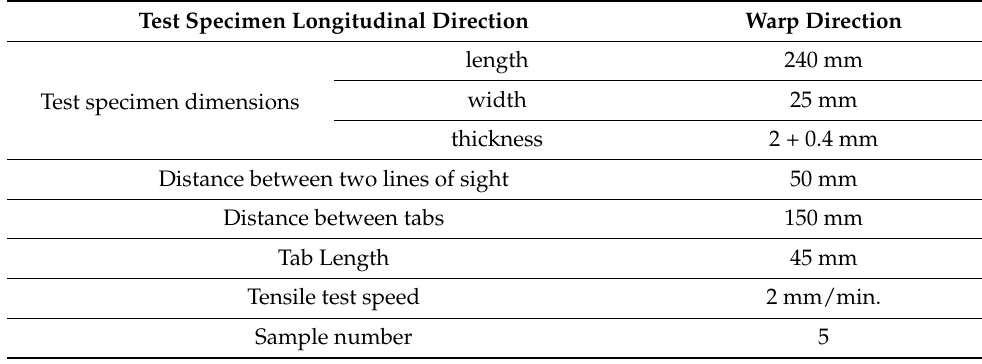
Table 6. Conditions of four-point flexural test.